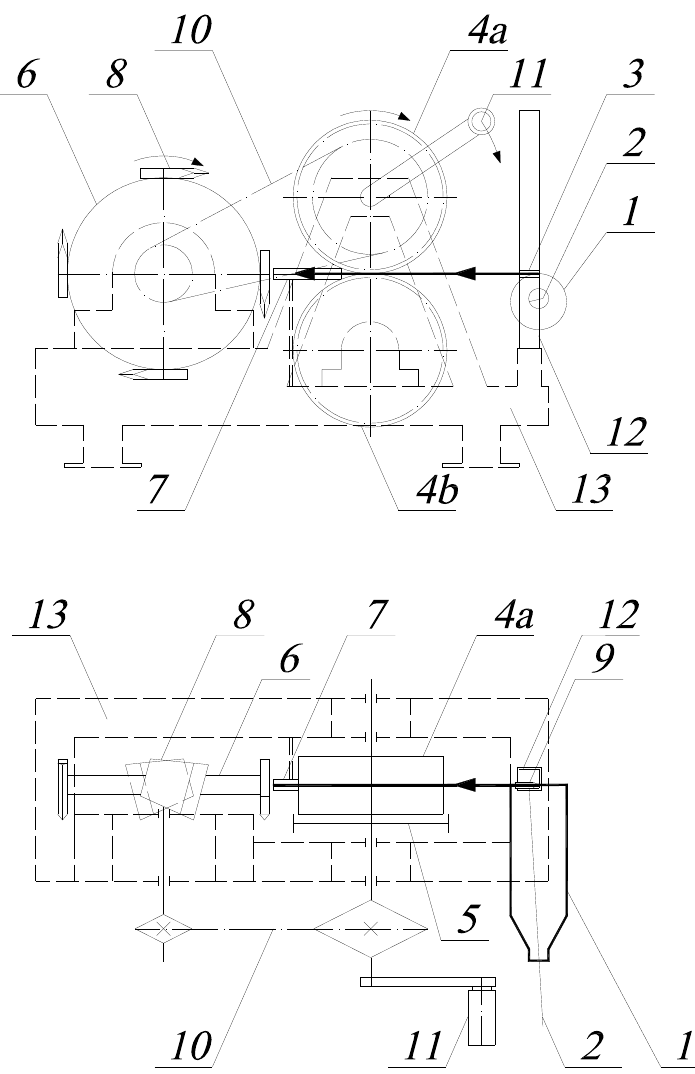
Figure 6. Schematic drawing of device for obtaining PET fibres.